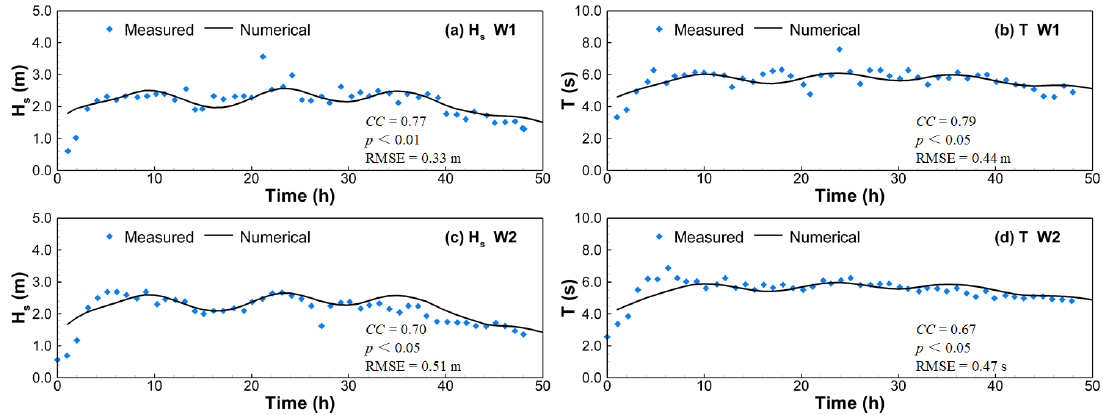
Figure 3. Validation of the wave model (run 5). ( a ) Significant wave height ( H s ) at W1. ( b ) Significant wave period ( T ) at W1. ( c ) Significant wave height at W2. ( d ) Significant wave period at W2.